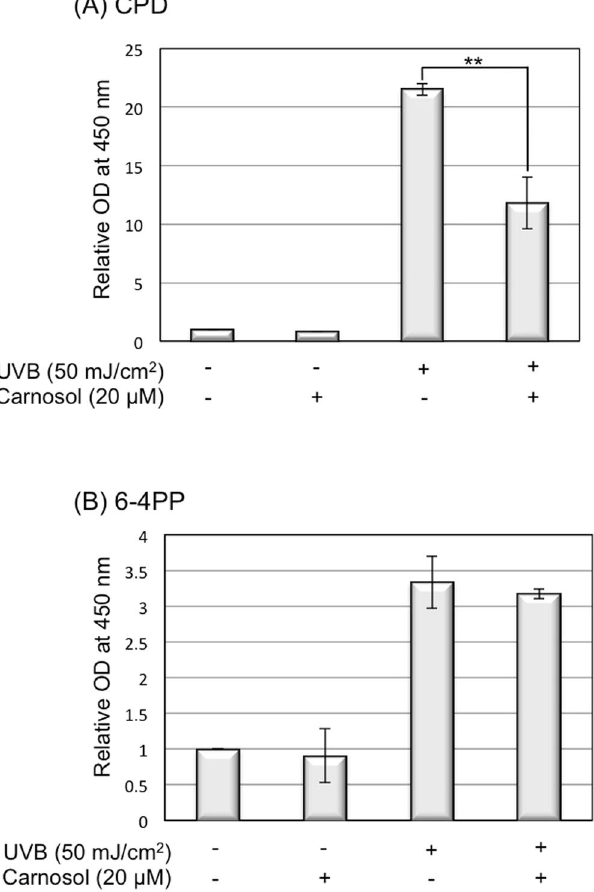
Figure 4. Carnosol reduces the formation of CPD upon UVB radiation. HaCaT cells (with or without carnosol treatment) were collected 15 minutes after 50 mJ/cm 2 UVB radiation. DNA was extracted from the cells and the production of CPD and 6–4 PP were detected by ELISA assay. ( A ) CPD quantitative detection. ( B ) 6–4 PP quantitative detection. ** p <